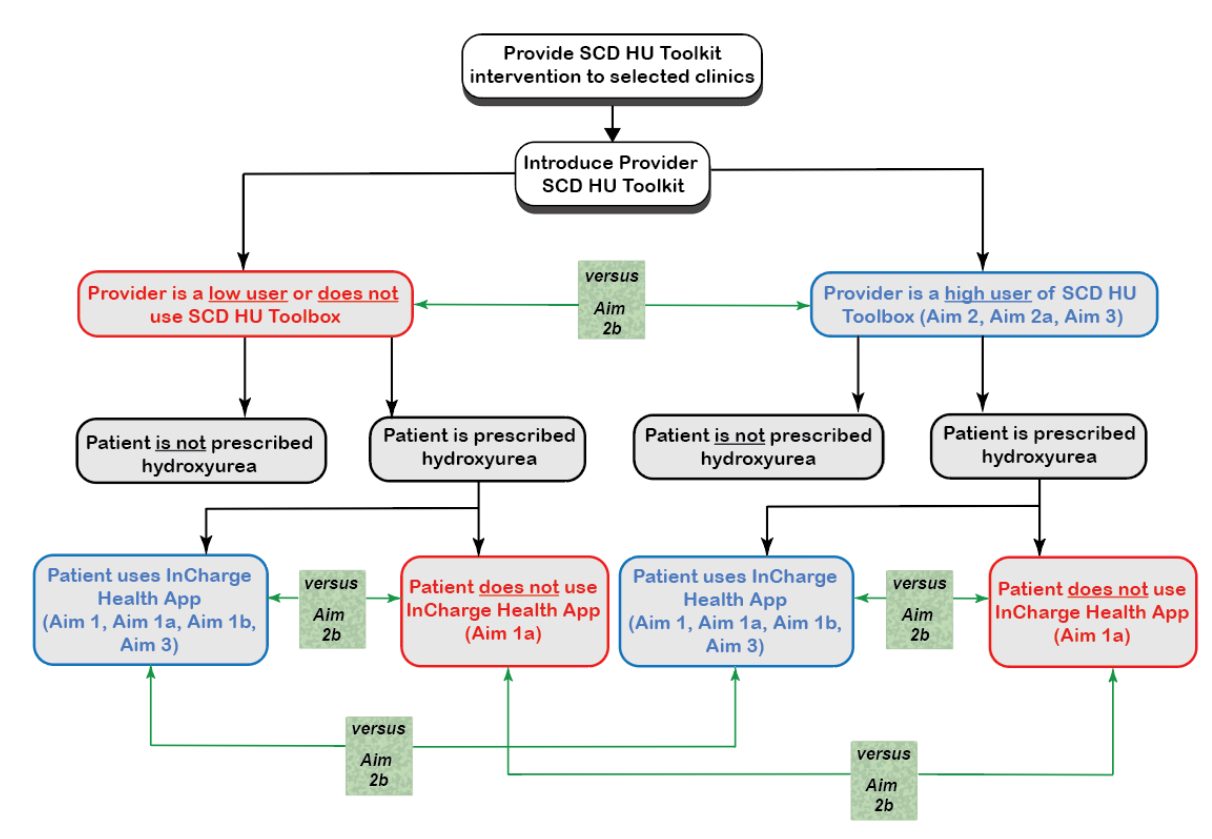
Figure 5. Study group comparisons according to each aim. The introduction and investigation of each intervention is performed sequentially. A total of 4 possible intervention combinations will be evaluated and compared: provider and patient use the intervention (patient and provider blue boxes), neither provider nor patient uses the intervention (patient and provider blue boxes), provider uses the intervention, but the patient does not (provider: blue box and patient: red box), and the patient uses the intervention, but the provider does not (provider red box and patient blue box). HU Toolbox: Hydroxyurea Toolbox; SCD: sickle cell